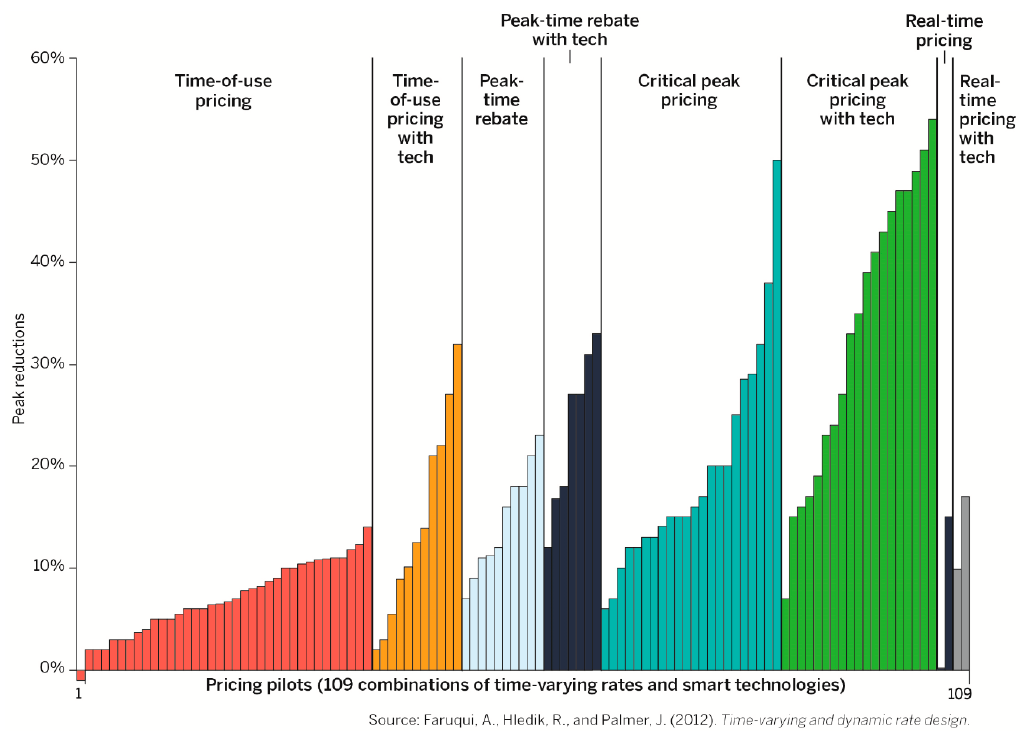
Figure 1. Average peak reduction from time-varying tariff pilots. Reproduced from Faruqui et al. [30].